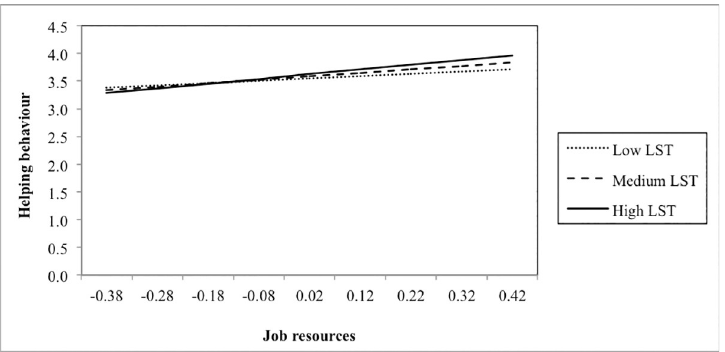
Fig 4. Interaction between job resources and low sensory threshold (LST) in predicting helping